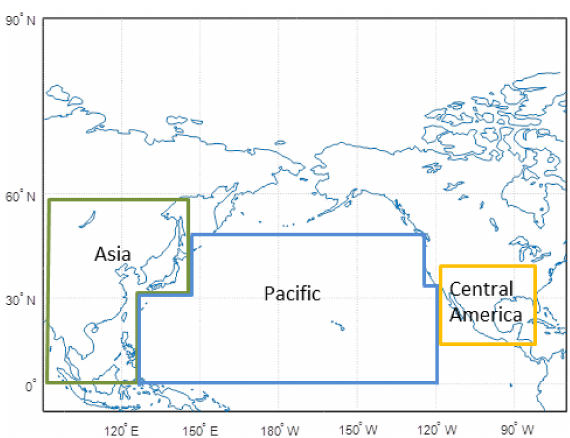
Figure 7. Geographical boundaries used to characterize the air parcels associated with the 12-day backward trajectories ending at TMF during the lidar measurements over the period